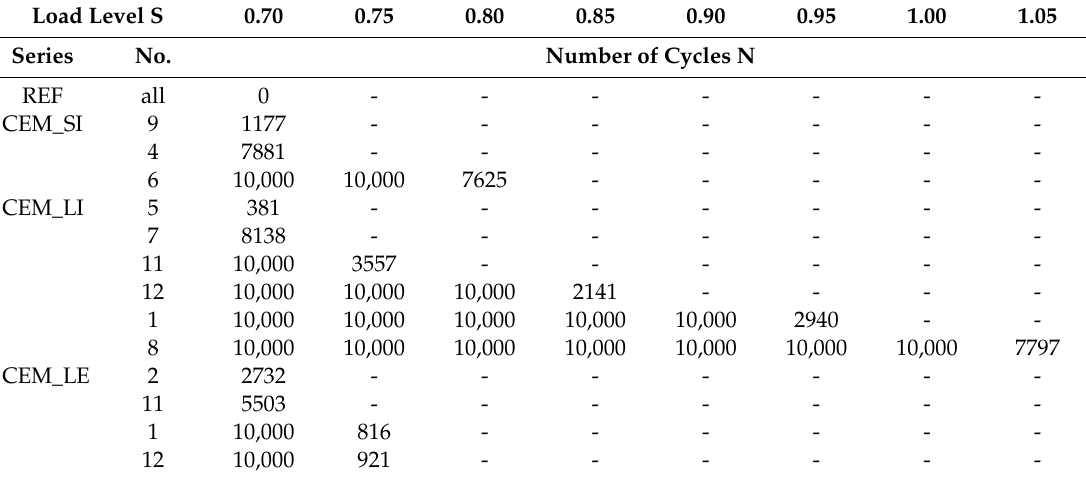
Figure 13. Peak crack opening versus number of cycles until complete failure, which occurred at different load level S among the specimens. Table 6. Number of cycles sustained by the specimens at each load level S.